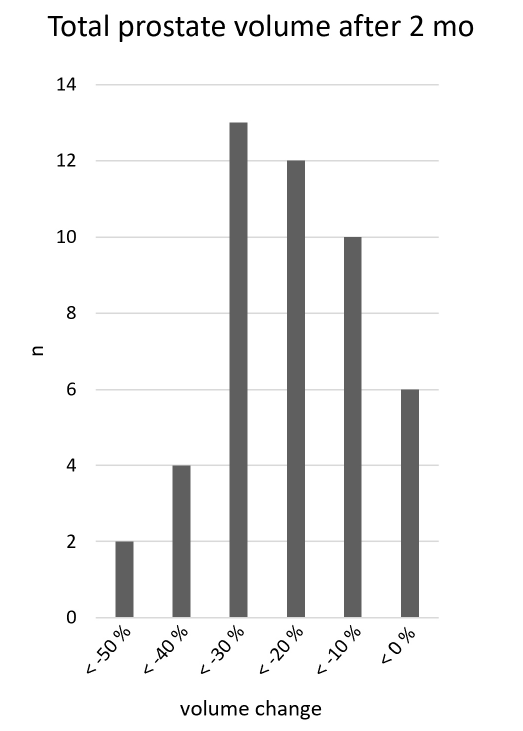
Fig. 2. Distribution of prostate volume reduction after 2 months. In most patients, the prostate volume was reduced be- tween 10% and 30%. In no case was the increase in prostate vol- ume observed.